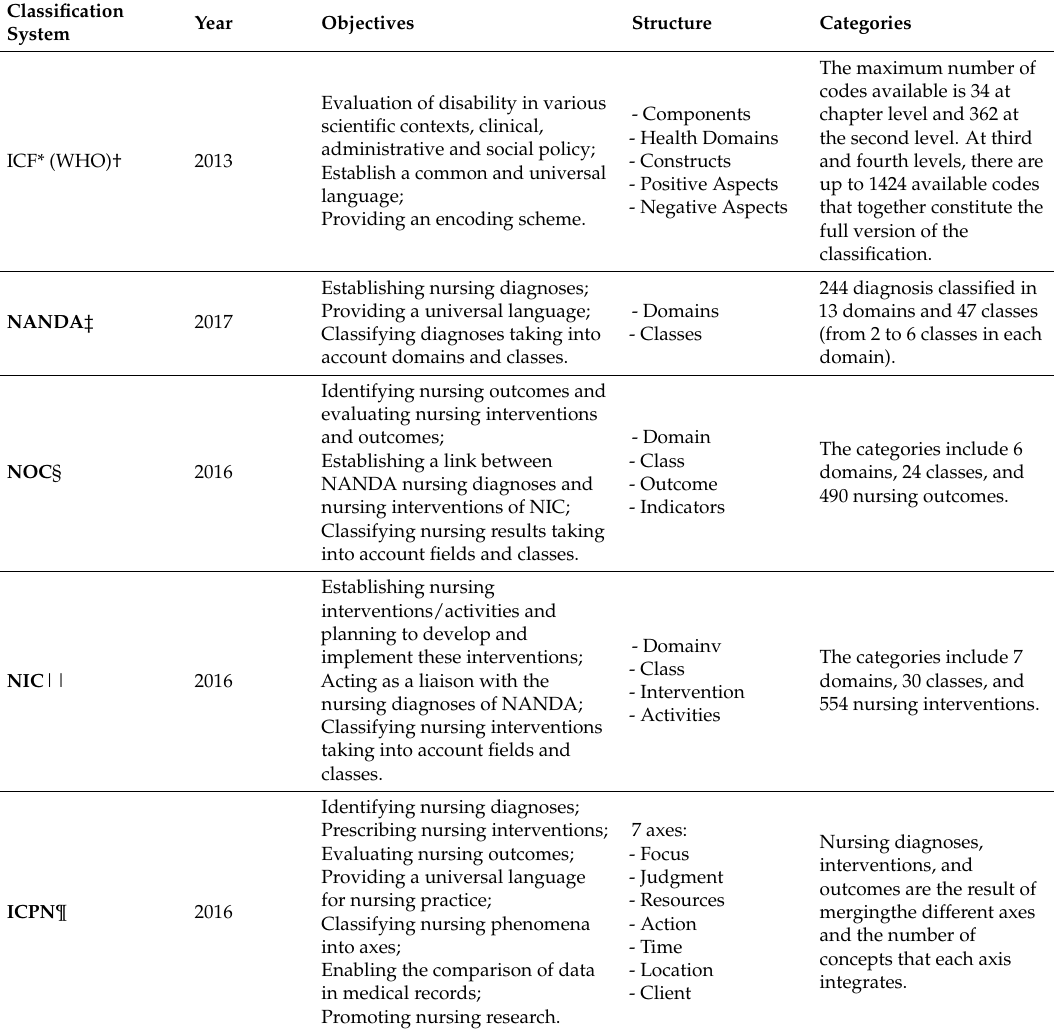
Table 1. Nursing classification